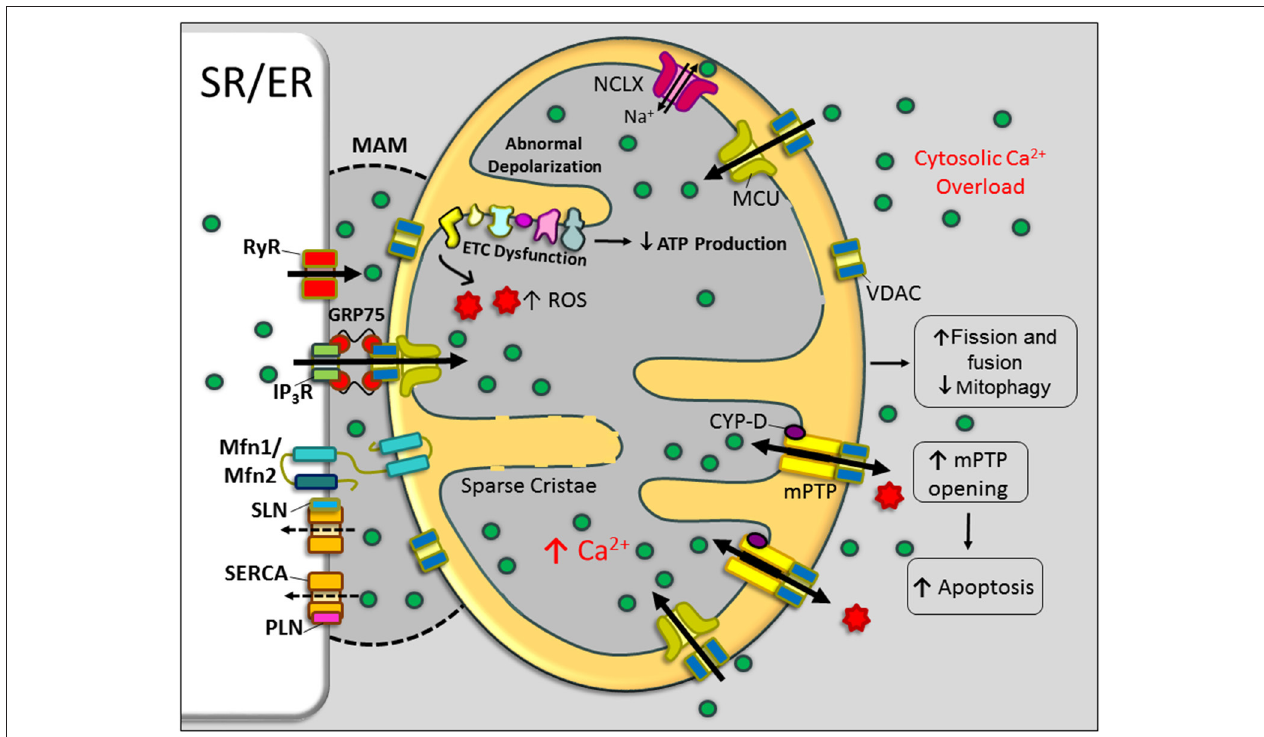
FIGURE 3 | Mitochondrial dysfunction in DMD. Schematic representation of mitochondrial structural and functional alterations in dystrophin-deficient cardiac/skeletal muscle cells. An abnormal elevation of Ca 2 + in the cytoplasm and mitochondria-associated membrane (MAM) region resulted in increased mitochondrial Ca 2 + uptake and enhanced activation of mitochondrial permeability transition pore (mPTP) opening. These changes impair mitochondrial function and mitochondrial dynamics and contributing to the metabolic crisis. Currently, there is no experimental evidence for the role of the MAM region and mitochondrial Ca 2 + uniporter (MCU) in the mitochondrial Ca 2 + overload in DMD. Bold and broken arrows indicate the enhanced and decreased function of the Ca 2 + channels, respectively. ER, endoplasmic reticulum; ETC, electron transport chain; GRP75, glucose-regulated protein 75; IP3R, inositol trisphosphate receptor; MFN, mitofusin; NCLX, Na + -Ca 2 + -Li + exchanger; PLN, phospholamban; ROS, reactive oxygen species; RyR, ryanodine receptor; SERCA, sarcoplasmic/endoplasmic reticulum Ca 2 + ATPase; SLN, sarcolipin; SR, sarcoplasmic reticulum; VDAC, voltage-dependent anion channel.